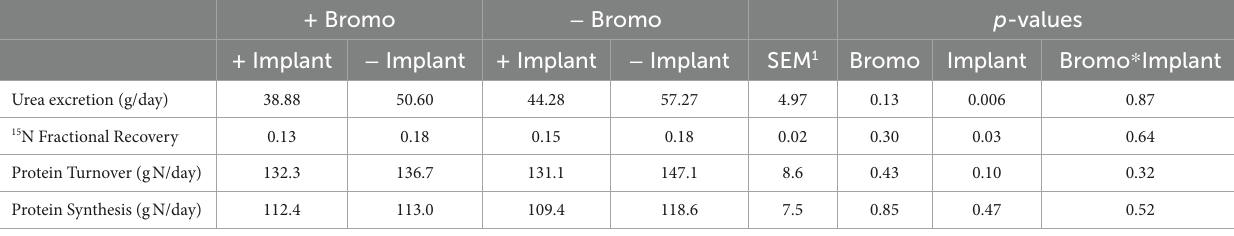
TABLE 3 Protein metabolism in steers treated with bromocriptine and estradiol/TBA implants. + Bromo − Bromo p -values + Implant − Implant + Implant − Implant SEM 1 Bromo Implant Bromo *